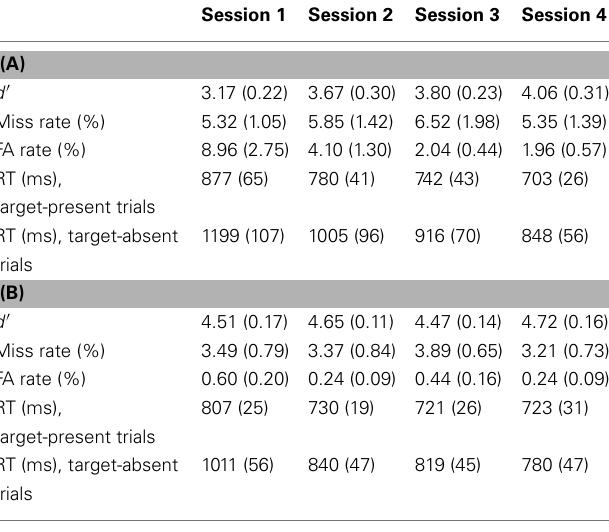
Table 1 |The summary of results in the experiment of (a) novices and (b) radiologists.